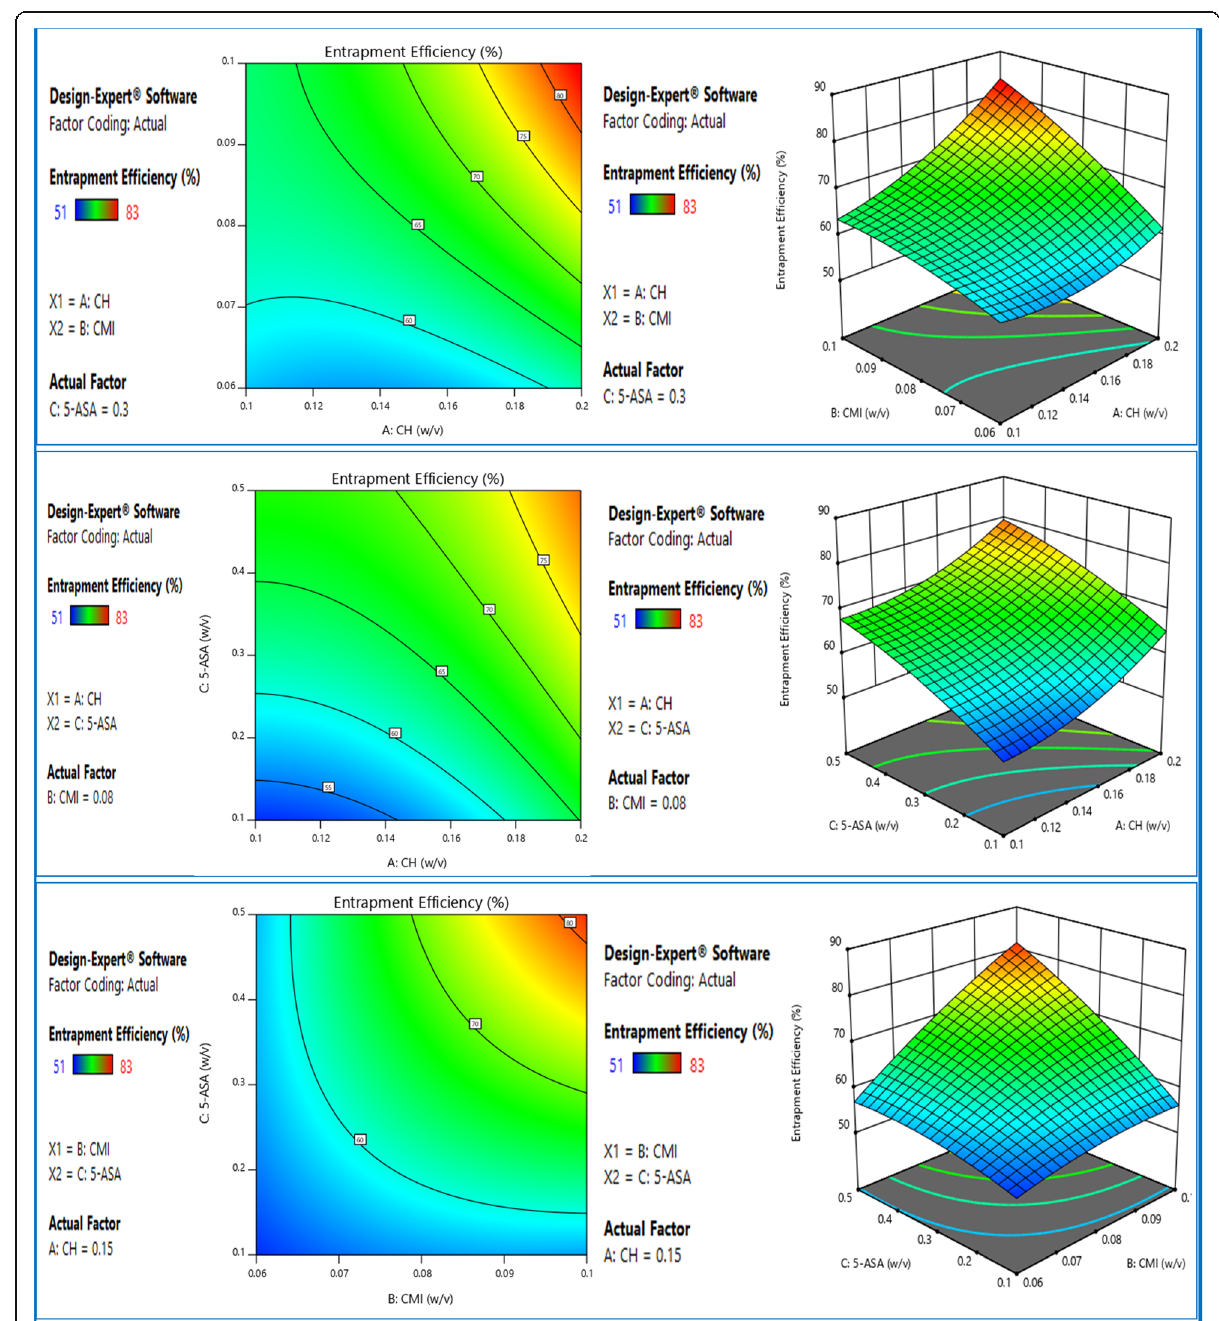
Fig. 6 2D-contour plots and 3D-response surface plots presenting the effect of independent variable on entrapment